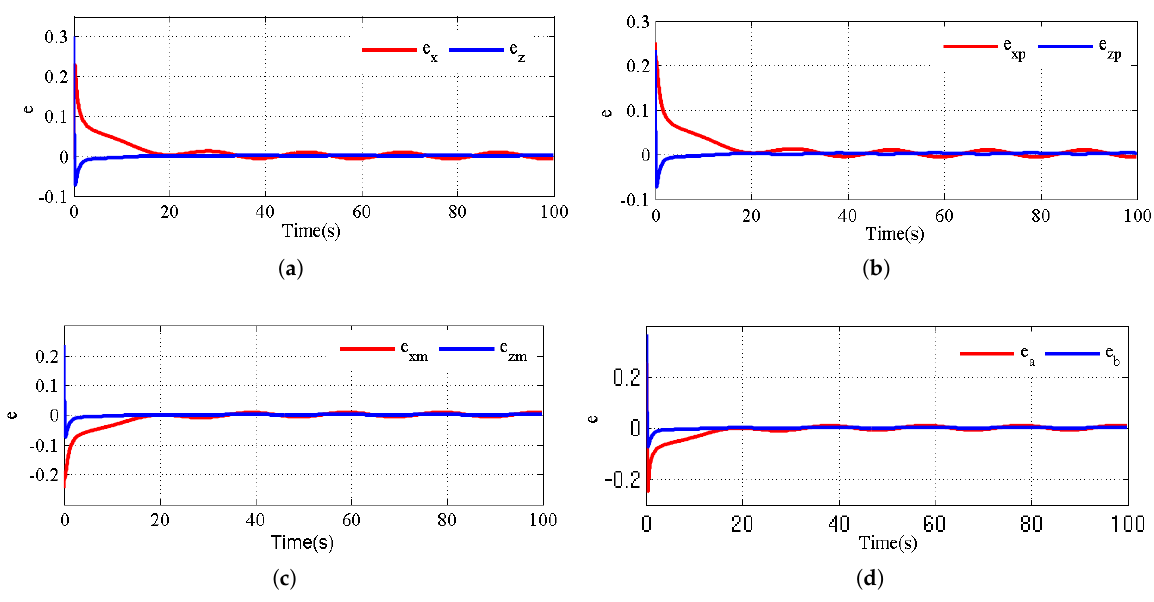
Figure 6. The control errors. ( a ) The errors e x and e z ; ( b ) the errors e xp and e zp ; ( c ) the errors e xm and e zm ; and ( d ) the errors e a and e b